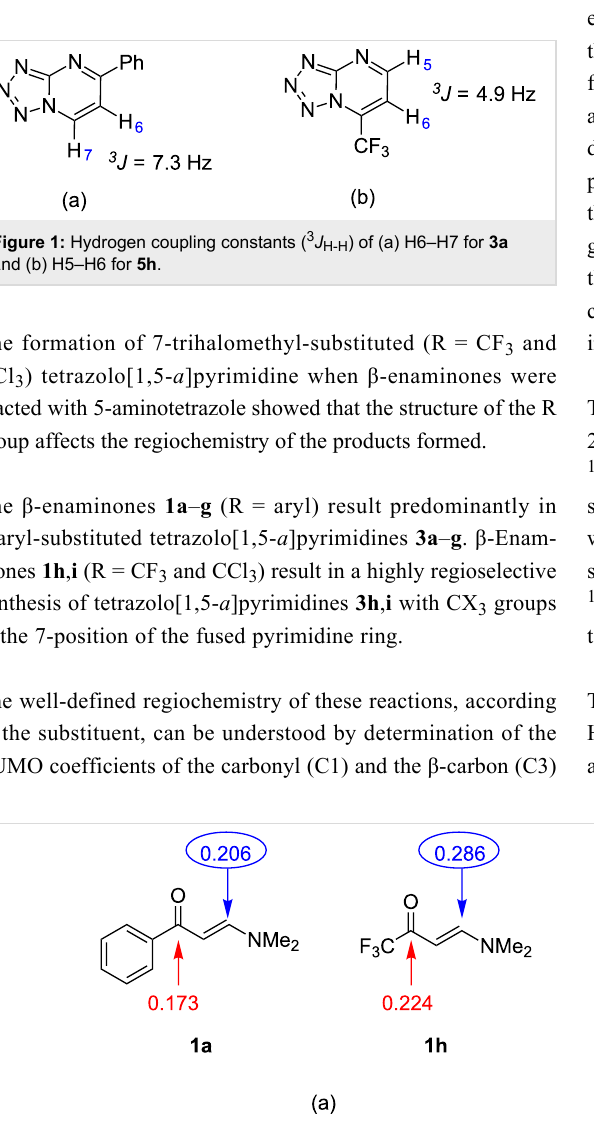
Figure 1: Hydrogen coupling constants ( 3 J H-H ) of (a) H6–H7 for 3a and (b) H5–H6 for 5h .